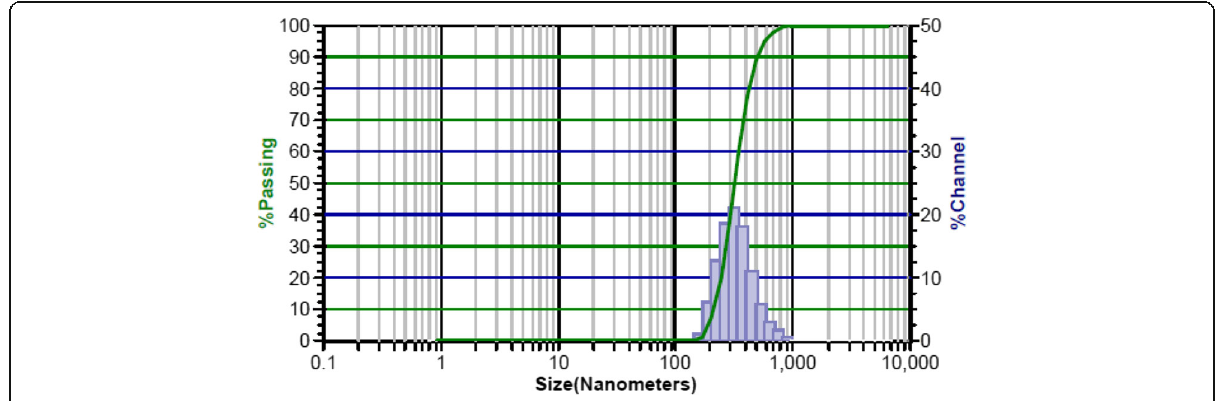
Fig. 5 Particle size distribution of optimum batch CCD5